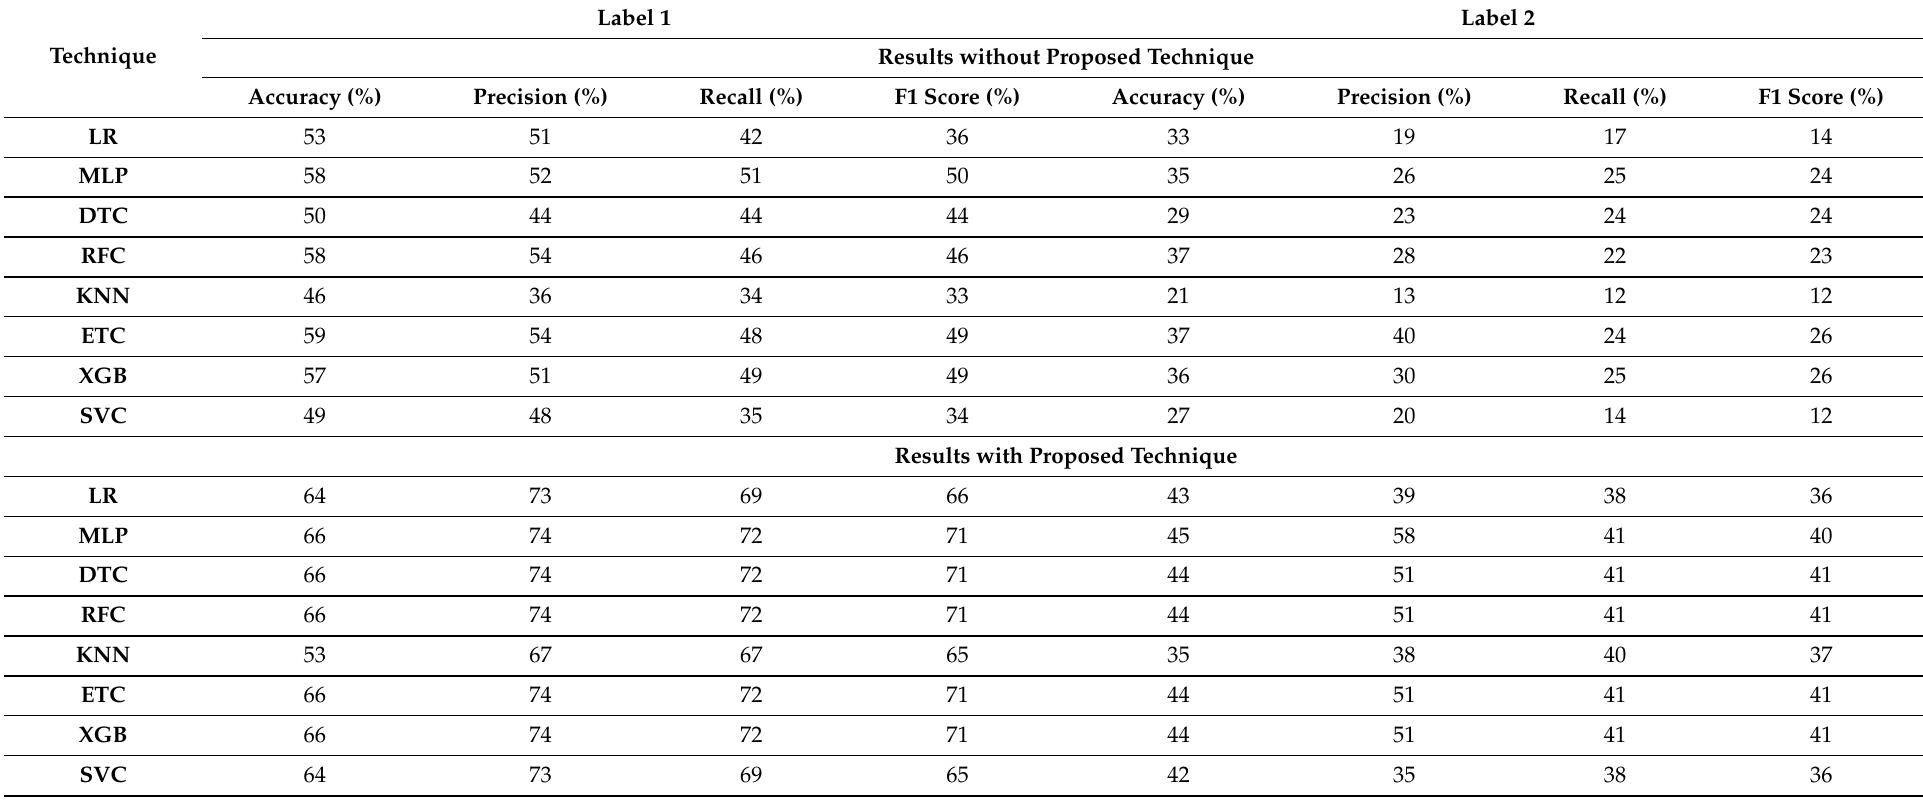
Table 4. Comparative analysis of machine learning models using an unbalanced dataset with a data split of